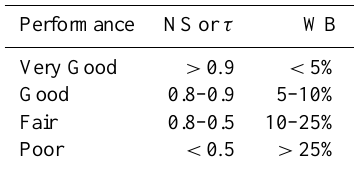
Table 3. Categories of model performance with the NS (monthly match), τ (monthly match of ranked values), and WB (bias in an- nual runoff) statistical